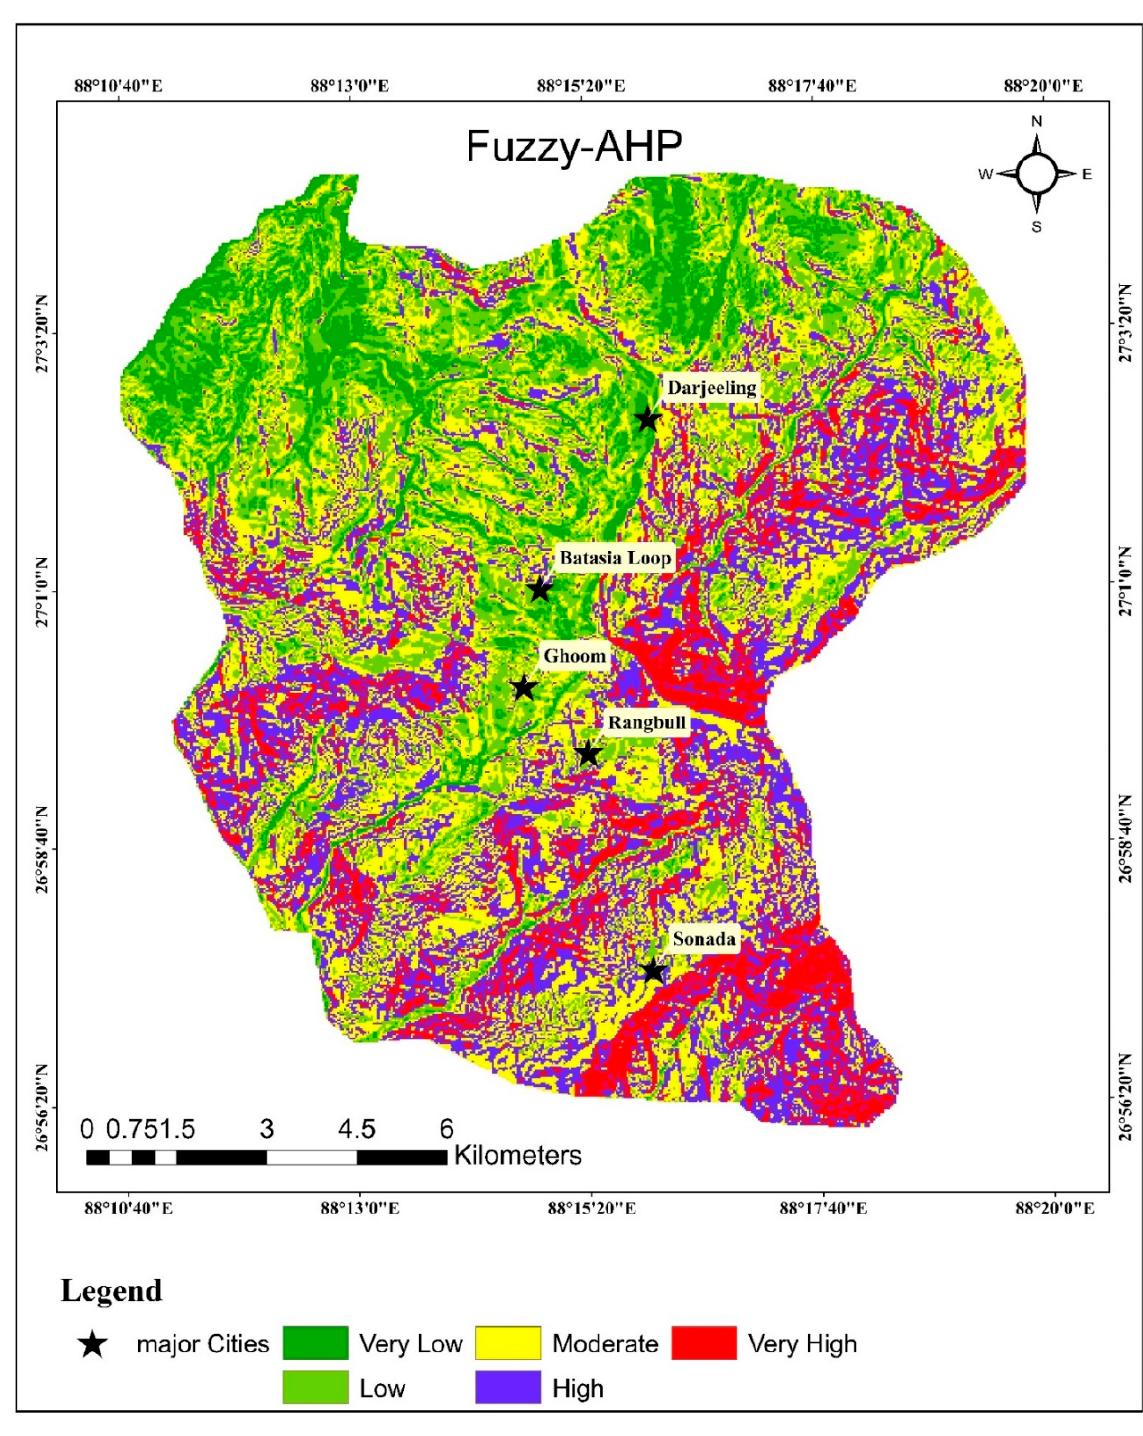
Figure 7. Landslide susceptibility map using fuzzy-AHP.